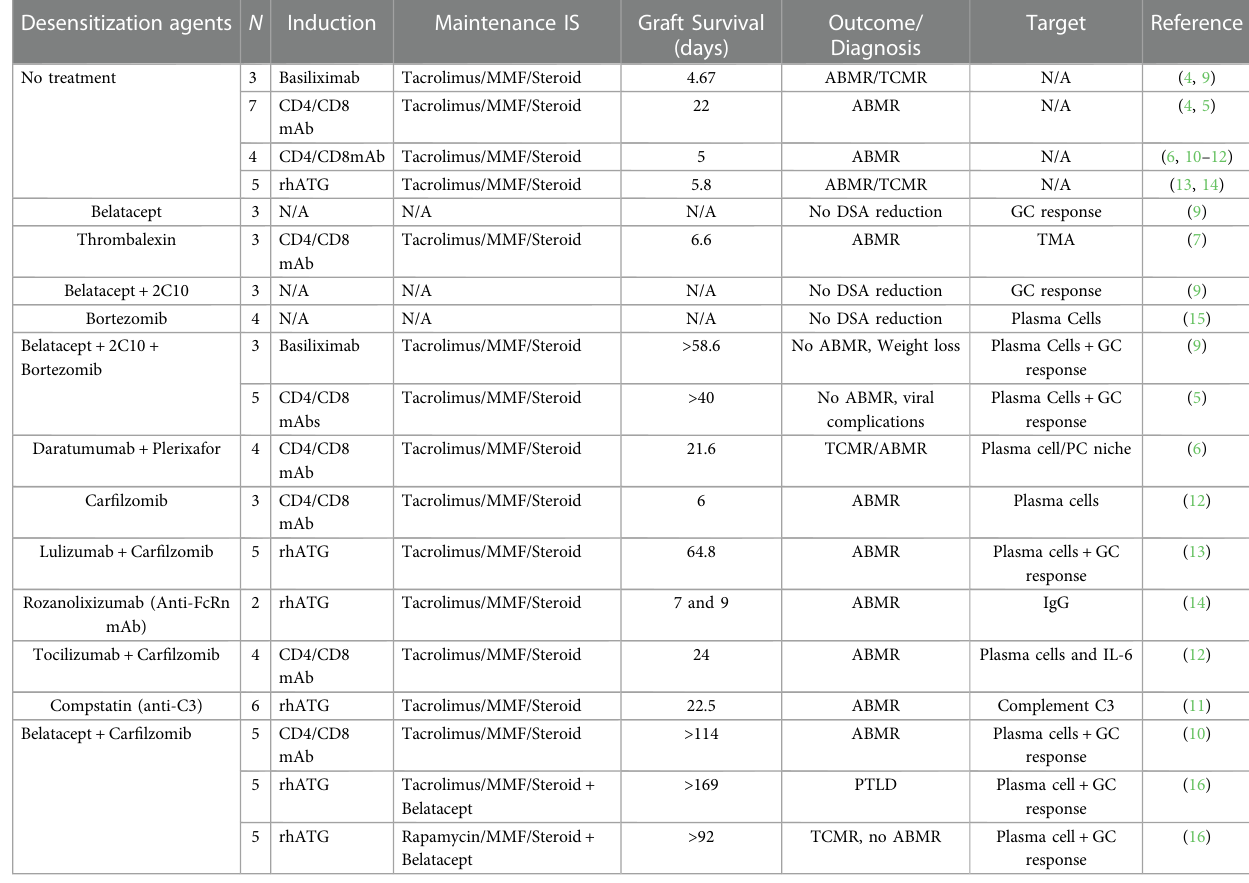
TABLE 1 Desensitization strategies tested in NHP preclinical model(s). Desensitization agents N